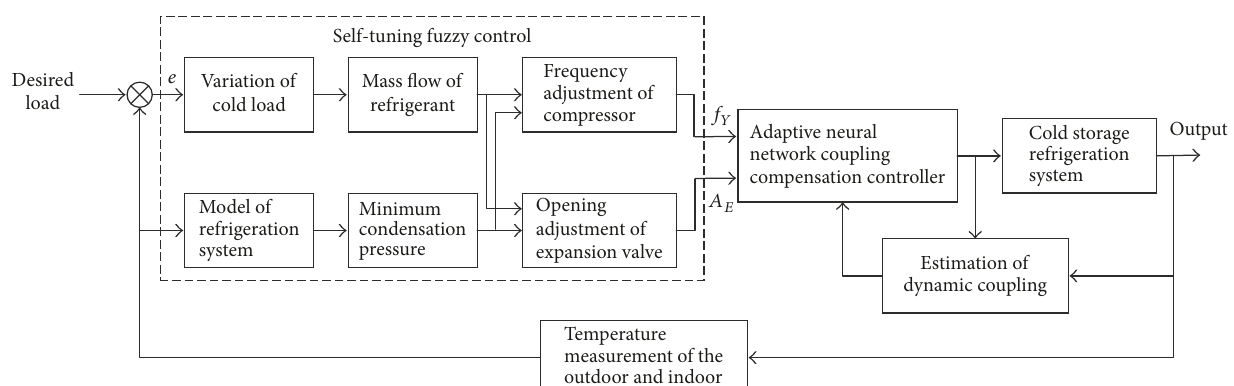
Figure 2: Fuzzy neural network controller with dynamic coupling